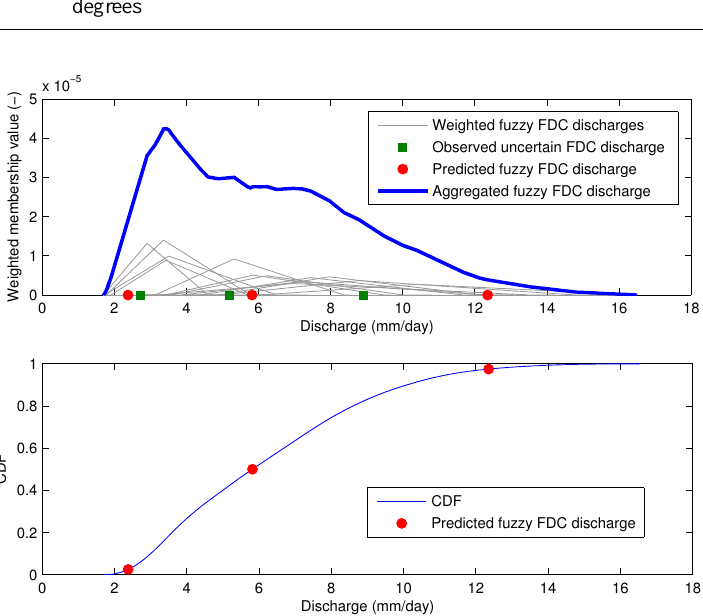
Figure 5. Regionalisation of uncertain FDCs using the general weighted mean operator for fuzzy numbers by Dubois and Prade (1980) for each EP. The individual membership functions for the fuzzy FDC discharge for each of the N surrounding stations were rescaled so that the area under the curves equalled the weights and then summed over the range of the support to a new membership function for the regionalised FDC (top panel). The 2.5, 50 and 97.5 percentiles of the cumulative distribution of the aggregated membership function were then used as lower, crisp and upper uncertainty bounds for the regionalised FDC (red